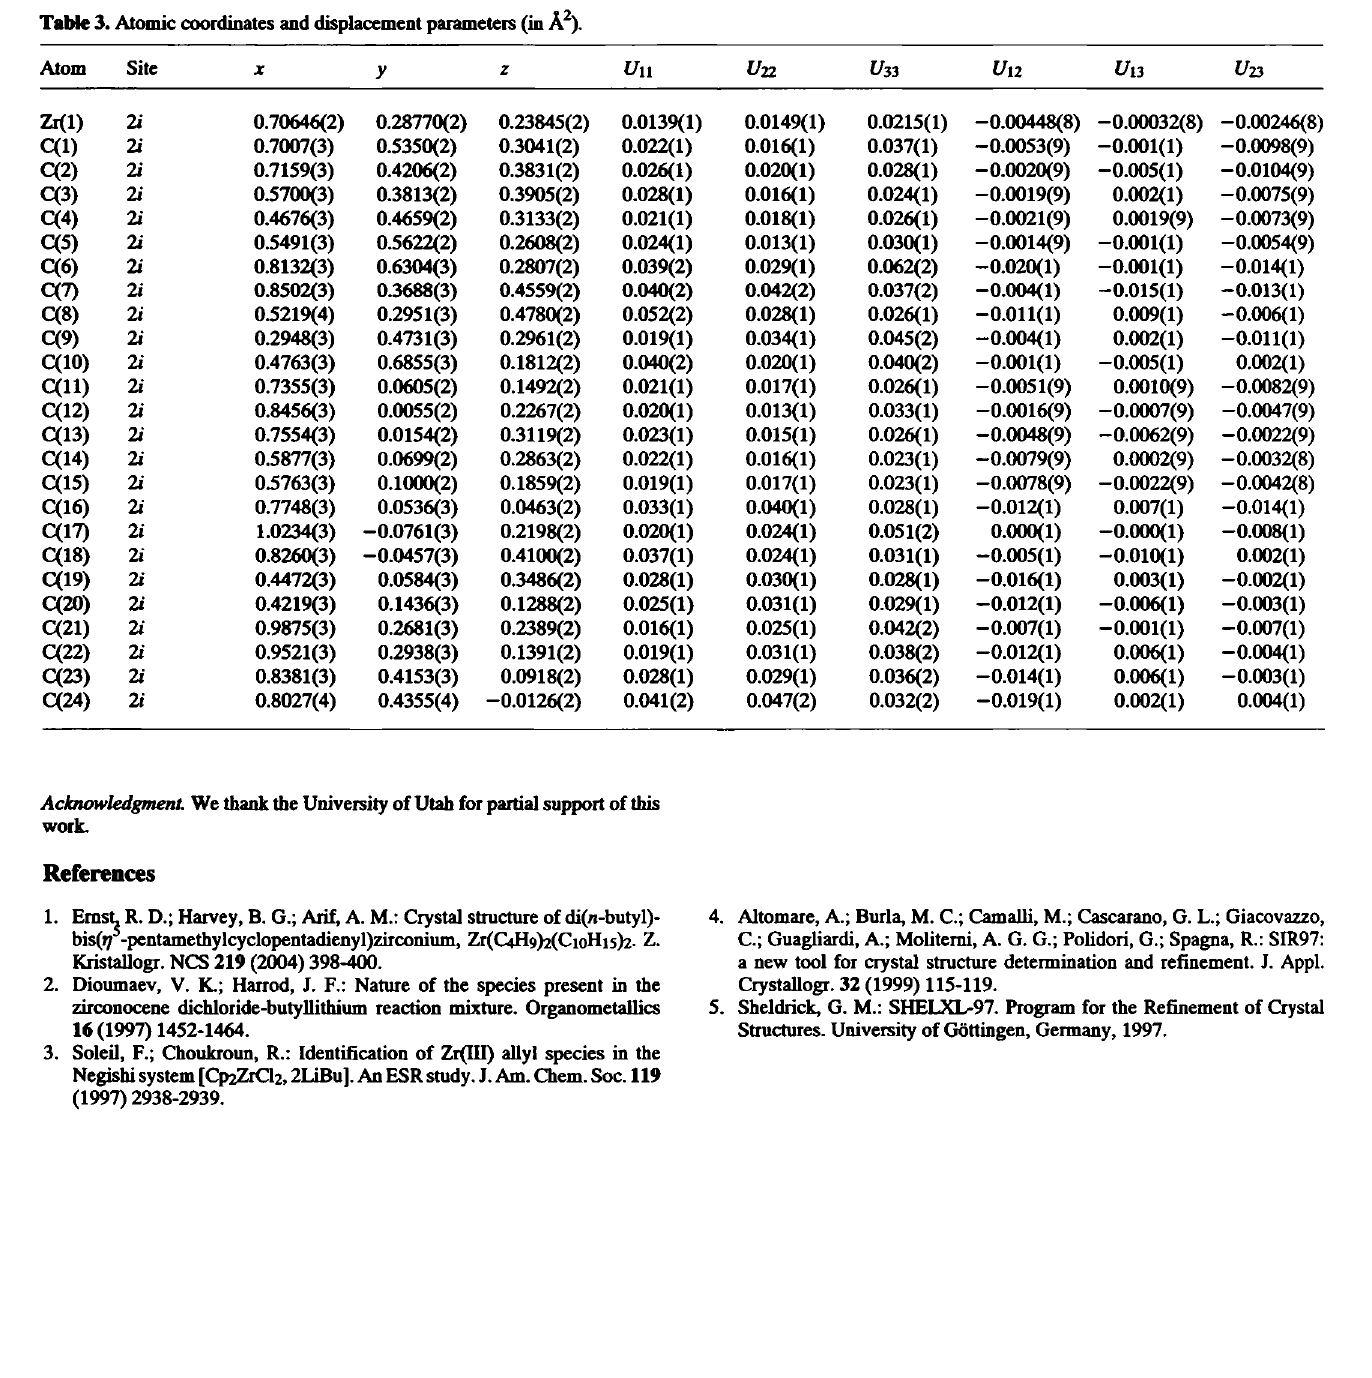
Table 3. Atomic coordinates and displacement parameters (in Ä 2